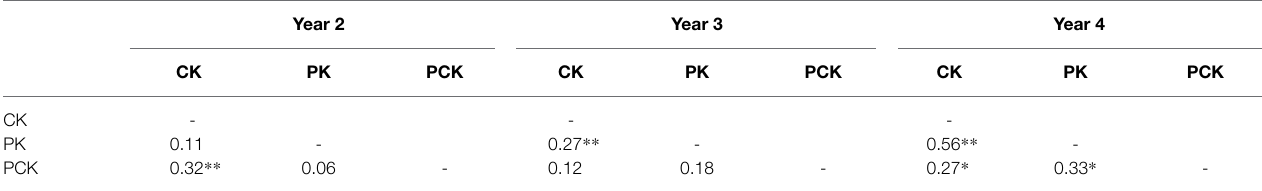
TABLE 3 | Correlation among three dimensions of professional knowledge for the second year to fourth year preservice English as a foreign language (EFL) teachers.